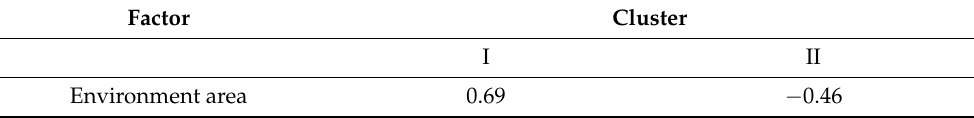
Table 12. Final cluster